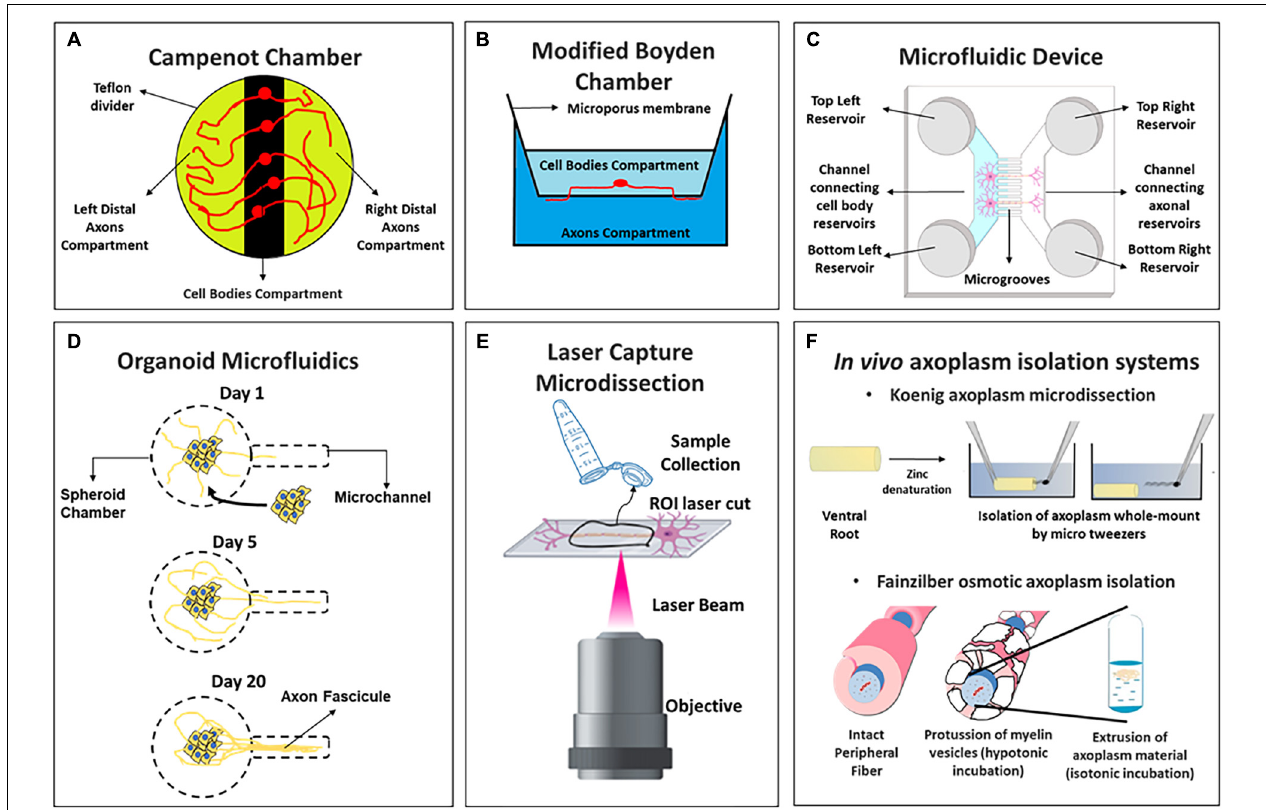
FIGURE 1 | Schemes of axoplasm isolation protocols compatible with omic approaches including (A) Campenot chambers, (B) Boyden modified chambers, (C) microfluidic device of two channels, (D) organoid microfluidics, (E) laser capture microdissection, and (F) in vivo axoplasm isolation systems (above the Koenig’s microdissection and below Fainzilber’s osmotic axoplasm